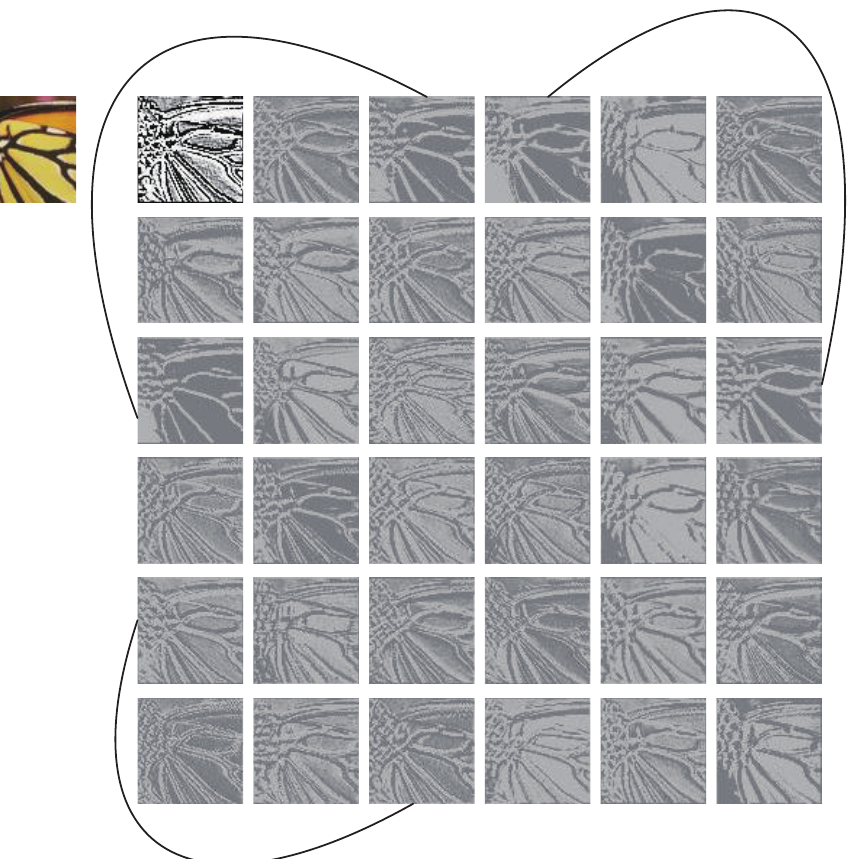
Figure 1. Visualization of some feature maps generated by the first residual block of RCAN. The feature map pairs connected by curves have strong